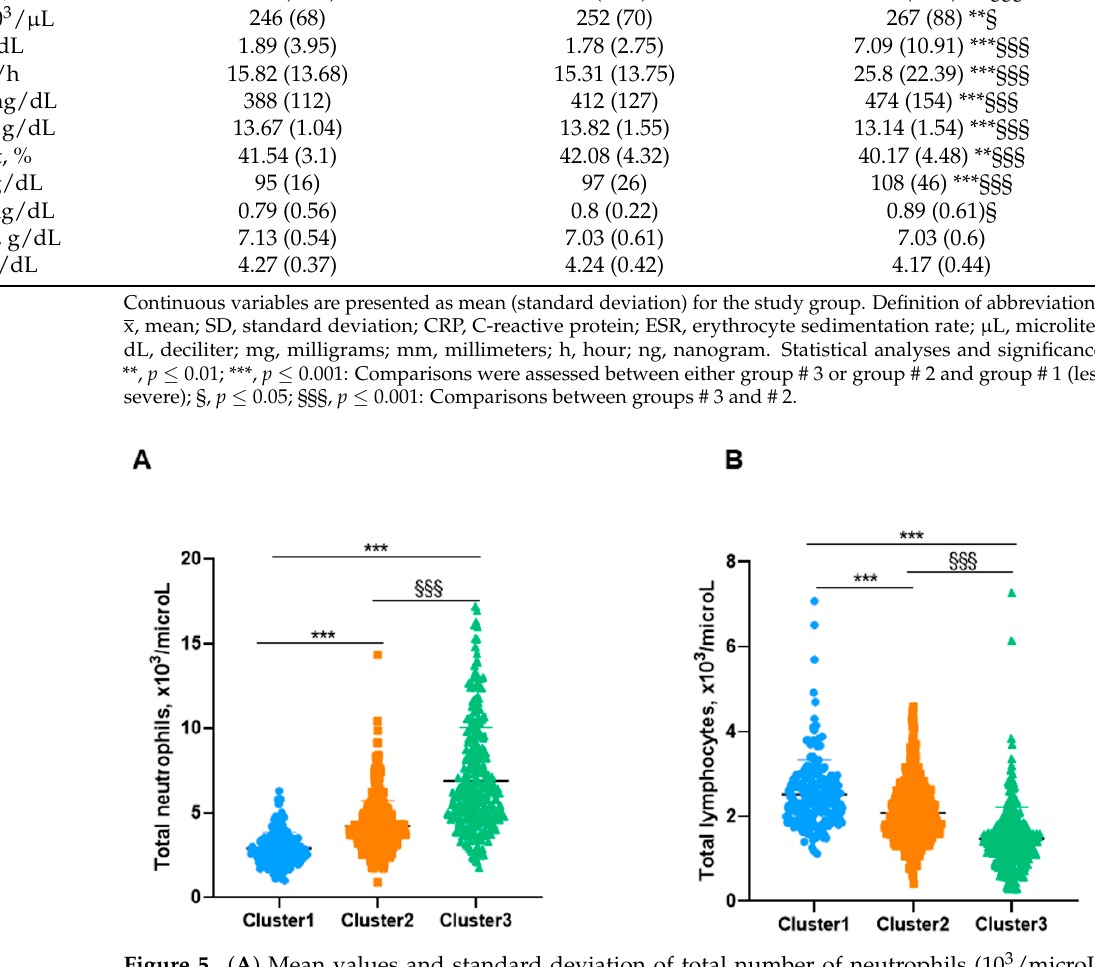
Figure 5. ( A ) Mean values and standard deviation of total number of neutrophils (10 3 /microL) among cluster 1, cluster 2, and cluster 3 in all the study patients. ( B ) Mean values and standard deviation of total number of lymphocytes (10 3 /microL) among cluster 1, cluster 2, and cluster 3 in all the study patients. Statistical significance: ***, p ≤ 0.001: Comparisons were assessed between either group # 3 or group # 2 and group # 1 (less severe §§§, p ≤ 0.001: Comparisons between groups # 3 and #